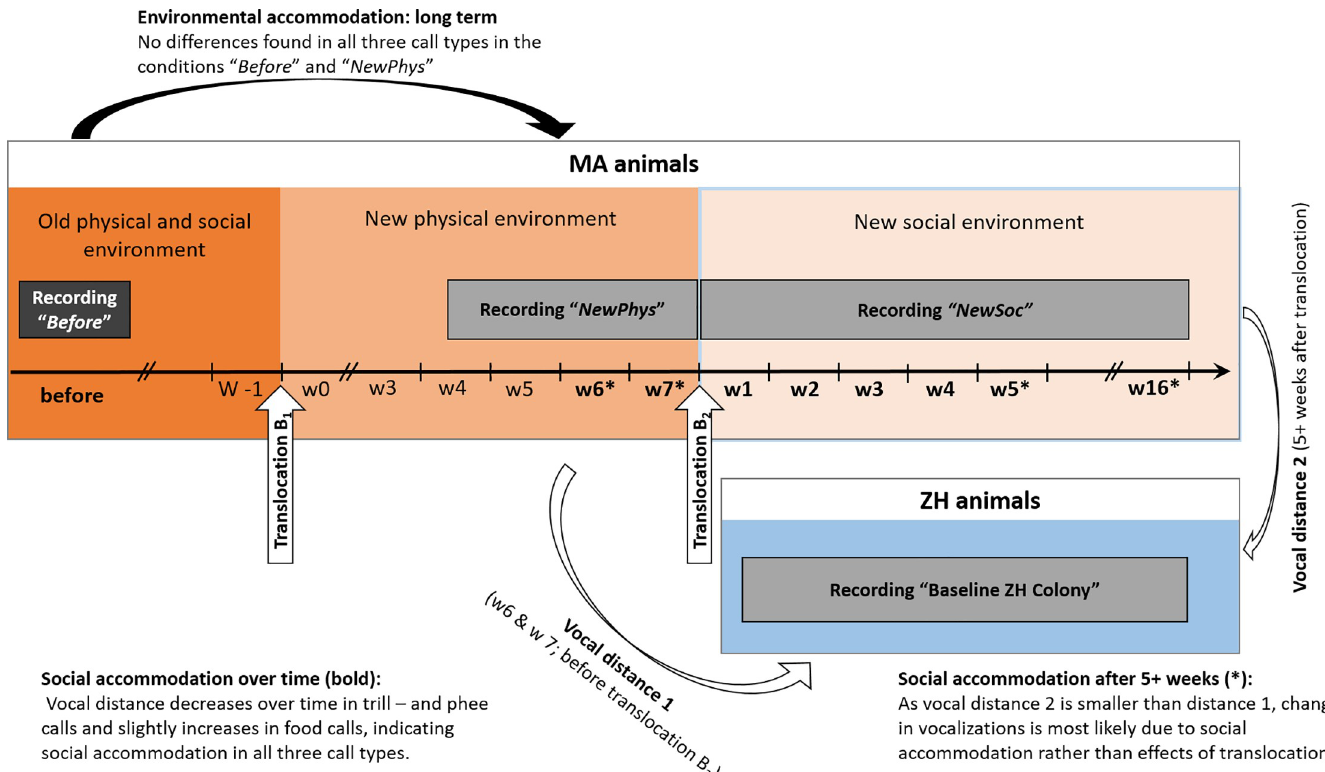
Fig 2. Timeline and comparisons of translocation B 1 and B 2 . The vocalizations of the animals from MA were first recorded in their home colony (old physical and social environment, recording “Before”). After that, they were translocated to a new physical environment (“Translocation B 1 ”, to a quarantine station, recording “NewPhys”), which allowed us to re-assess long term environmental accommodation (black arrow). Their calls did not differ before and after the translocation B 1 to the new physical environment. Next, the animals were translocated to the ZH colony (“Translocation B 2 ”, to a new social (and physical) environment, recording “NewSoc”). To quantify the social accommodation over time , we measured the vocal distance before any new social vocal contacts, during the weeks 6 & 7 after translocation B 1, as well as immediately after the animals arrived in the new colony and up to week 16, (weeks labelled in bold). To test for social accommodation after 5+ weeks of contact with the new colony (when potential short-term environmental accommodation effects must have disappeared), we compared the vocal distance (white arrows) between the animals from the ZH colony (“Baseline ZH Colony”) and the MA animals, immediately before Translocation B 2 (vocal distance 1) and after they were 5+ weeks in the new social environment (after “Translocation B 2 ”; vocal distance 2, weeks with � ). We found that after translocation to the new social environment, the vocal distance between the MA and the ZH animals decreased in two call types and slightly increased in the third call type, as well as remained smaller / larger also after 5+ weeks, which is indicative of social